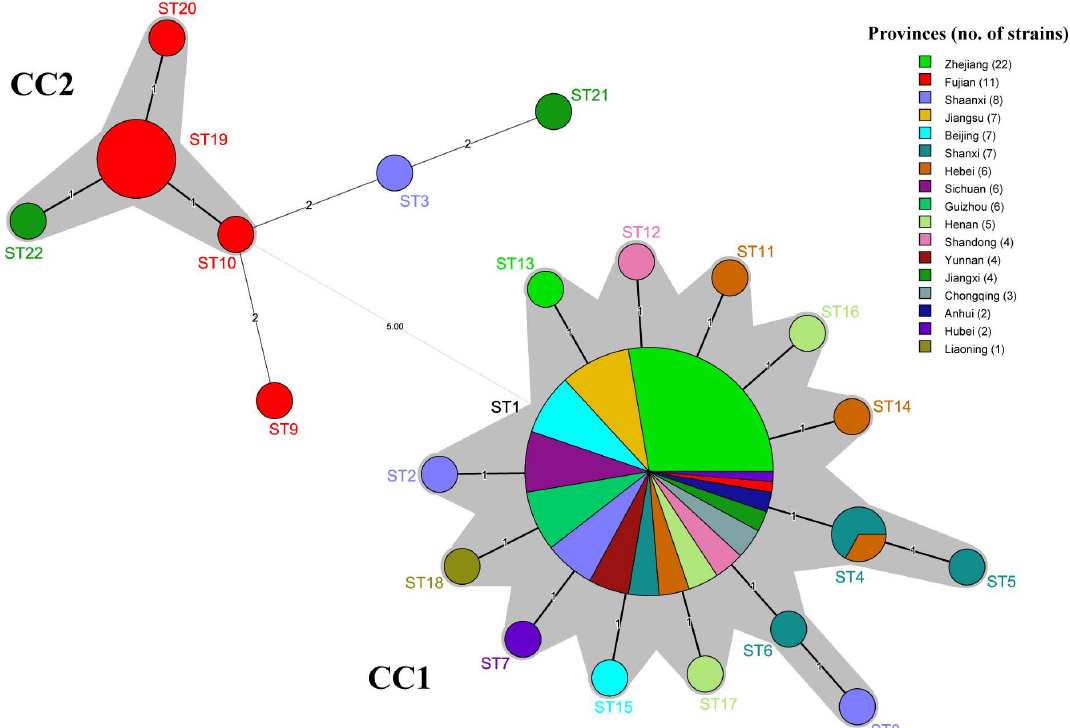
Figure 6. Minimum spanning tree of STs of 105 PaWB phytoplasma strains based on different provinces. Each circle represents a sequence type (ST). The shadow part was the two clonal complexes. The black thick solid lines indicated the closest genetic relationship, the black thin solid lines indicated that the closer genetic relationship, and the dotted lines indicated a further genetic relationship. The number above links represented the number of locus differences, and the size of circles represented the number of